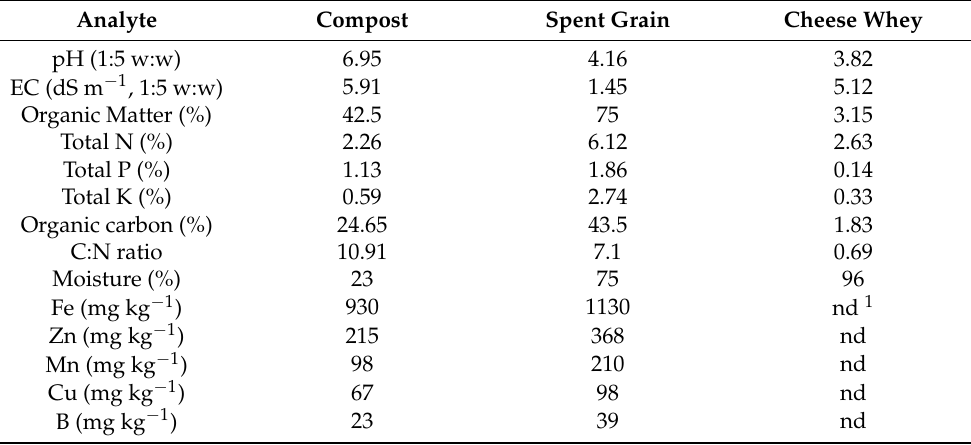
Table 1. Characterization of organic amendments used in this study (oven dry weight basis). Analyte